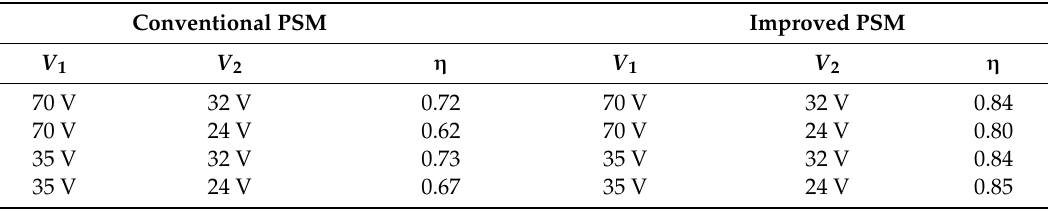
Table 3. Efficiency at full power in case of SOSC recharge, as resulting from simulation.